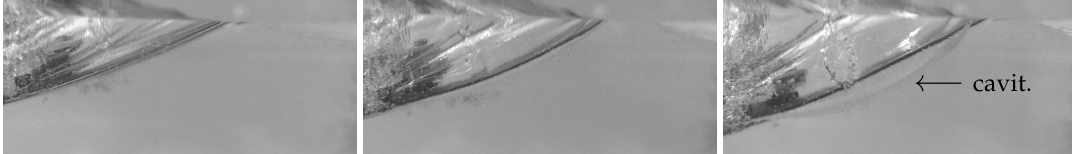
Figure 10. Evolution of the water entry of a wedge (W) ( β = 30 ◦ ) entering the water at 40, and 55 ms from the impact.